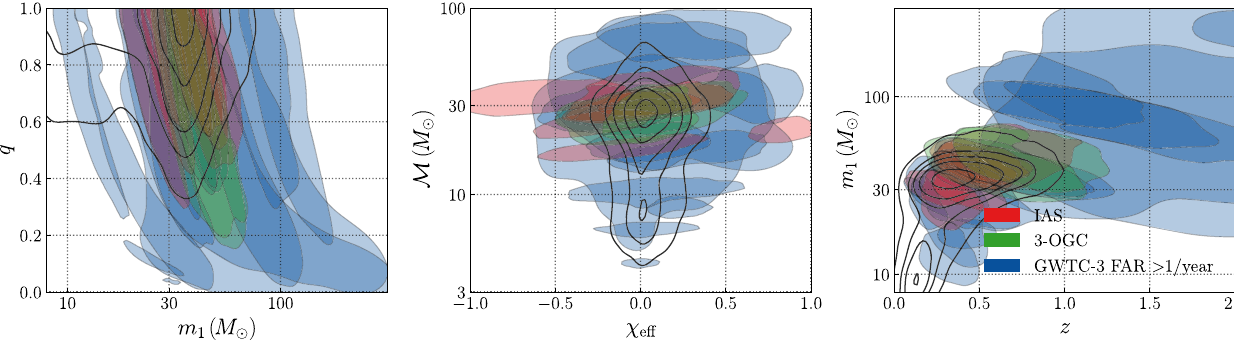
FIG. 22. The measured properties of the BBH candidates not included in the population study presented in this paper (shaded regions), compared to the inferred population from the PP model presented in Sec. VI A (black contours). These include both events which fall below our FAR threshold as well as events identified by other groups. The events are color coded based upon the search which first identified them: catalogs from O1 and O2 [72 – 74] in red, events from the third Open Gravitational-Wave Catalog (3-OGC) (which incorporates events in O1 – O3a) [76] in green, and from GWTC-3 with FAR > 1 yr − 1 threshold in